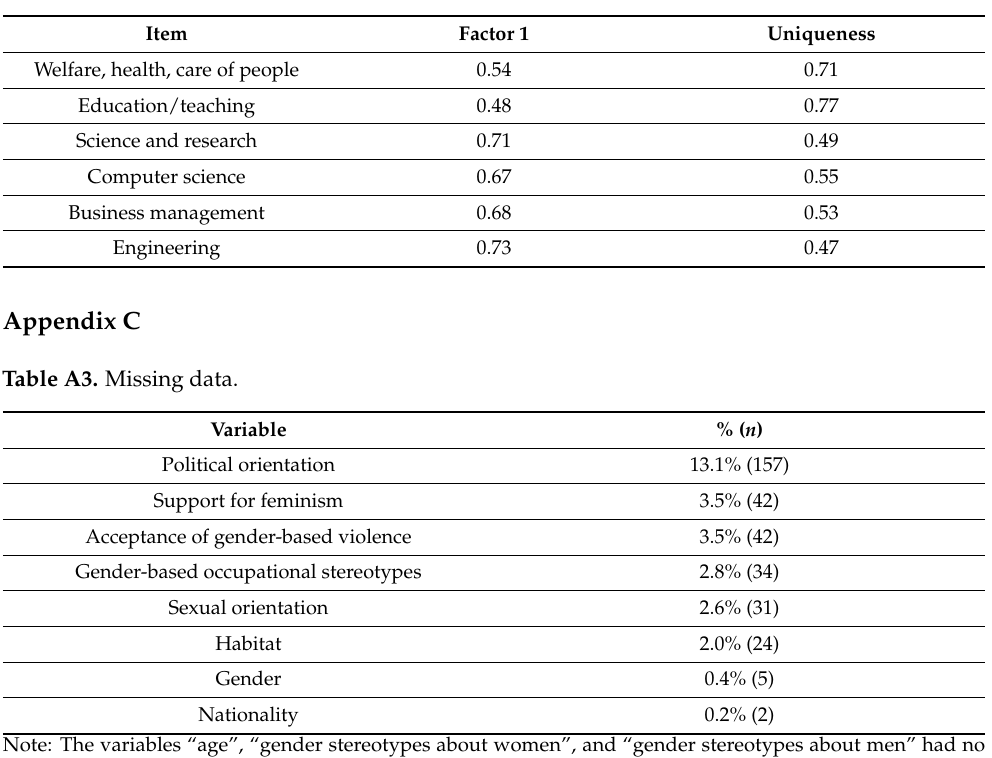
Table A2. Factor loadings of the six items measuring gender-based occupational stereotypes.